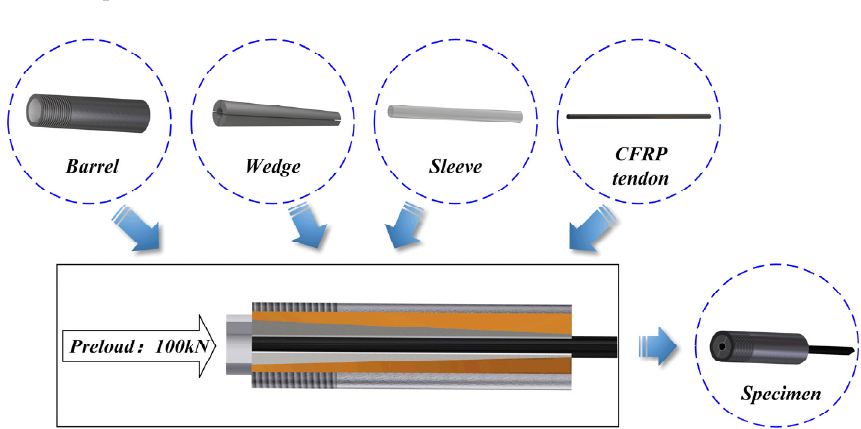
Figure 2. Fabrication process of the anchoring system.